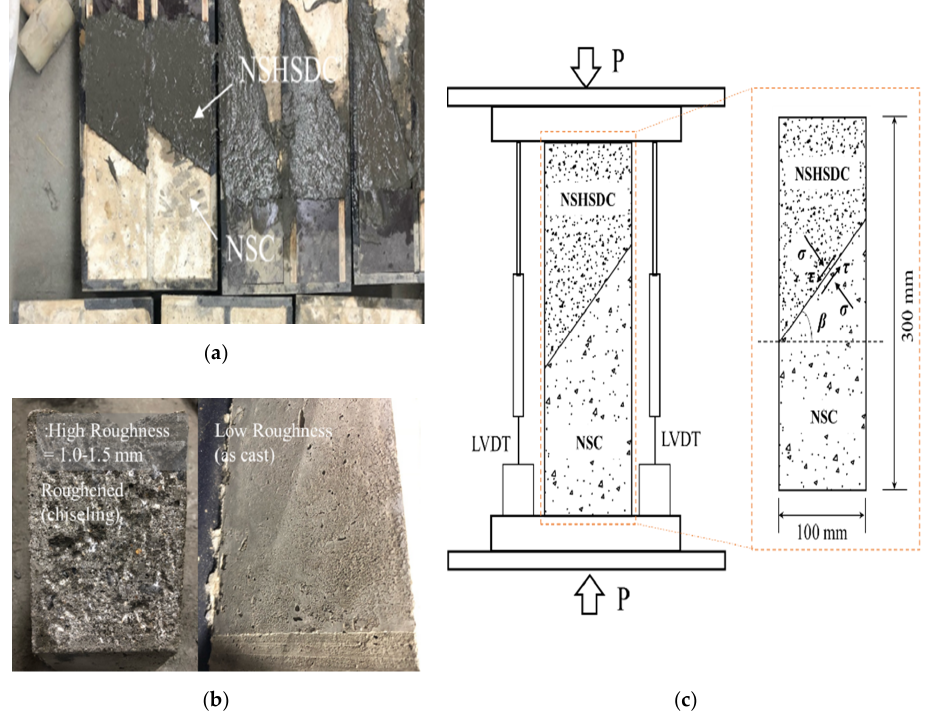
Figure 1. Slant shear test: ( a ) Production of the prismatic specimens, ( b ) Interface condition, ( c ) Test